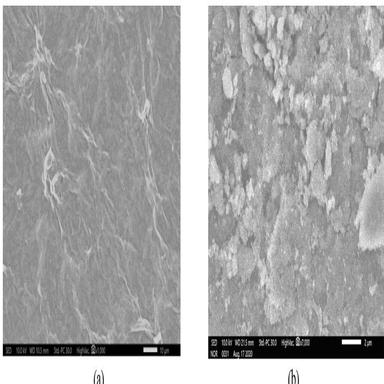
SEM images of (a) GO, (b) FG2I, and (c) FG2E.